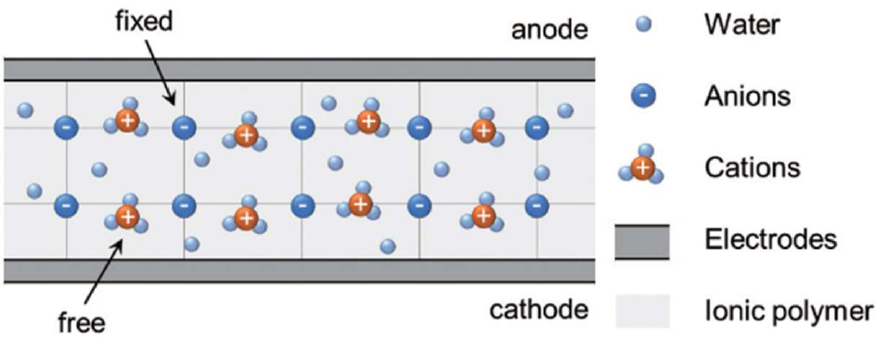
Figure 1. Structure diagram of IPMC [23].